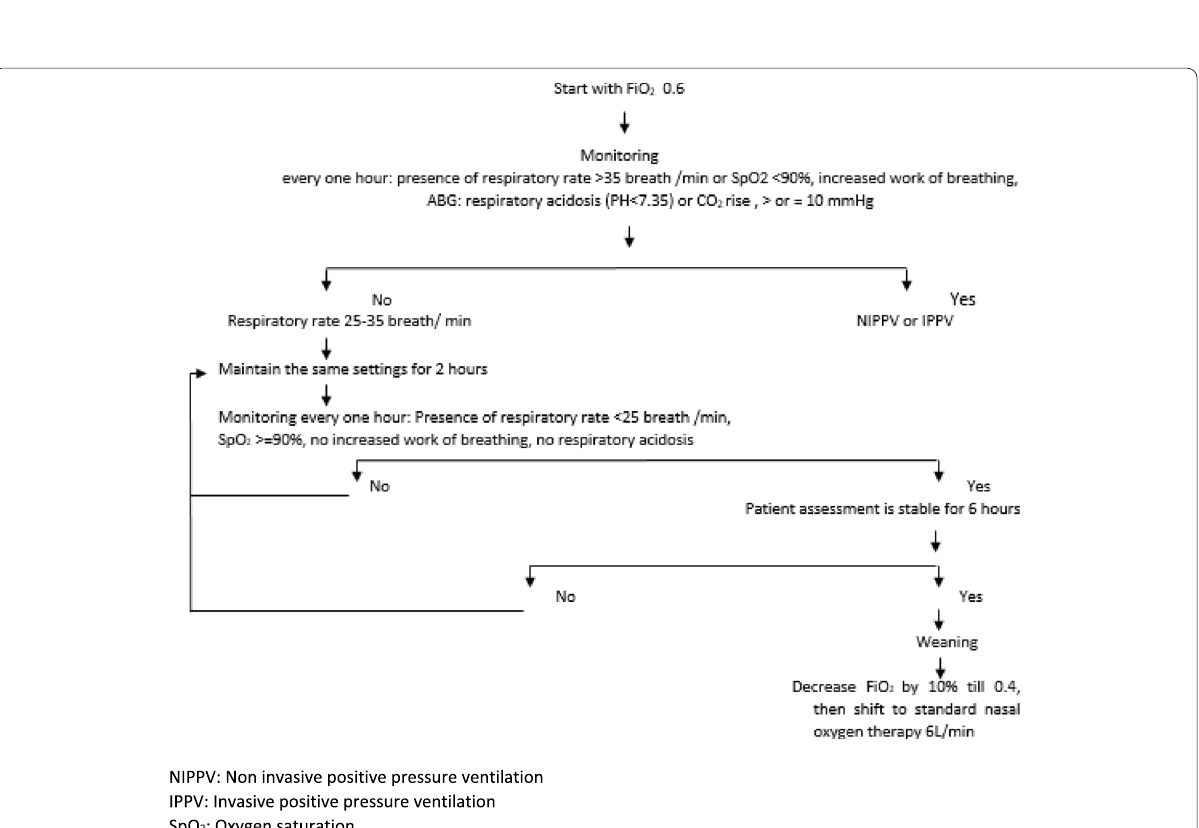
Fig. 2 Venturi mask oxygen therapy algorithm. NIPPV, non-invasive positive pressure ventilation; IPPV, invasive positive pressure ventilation; SpO 2 , oxygen